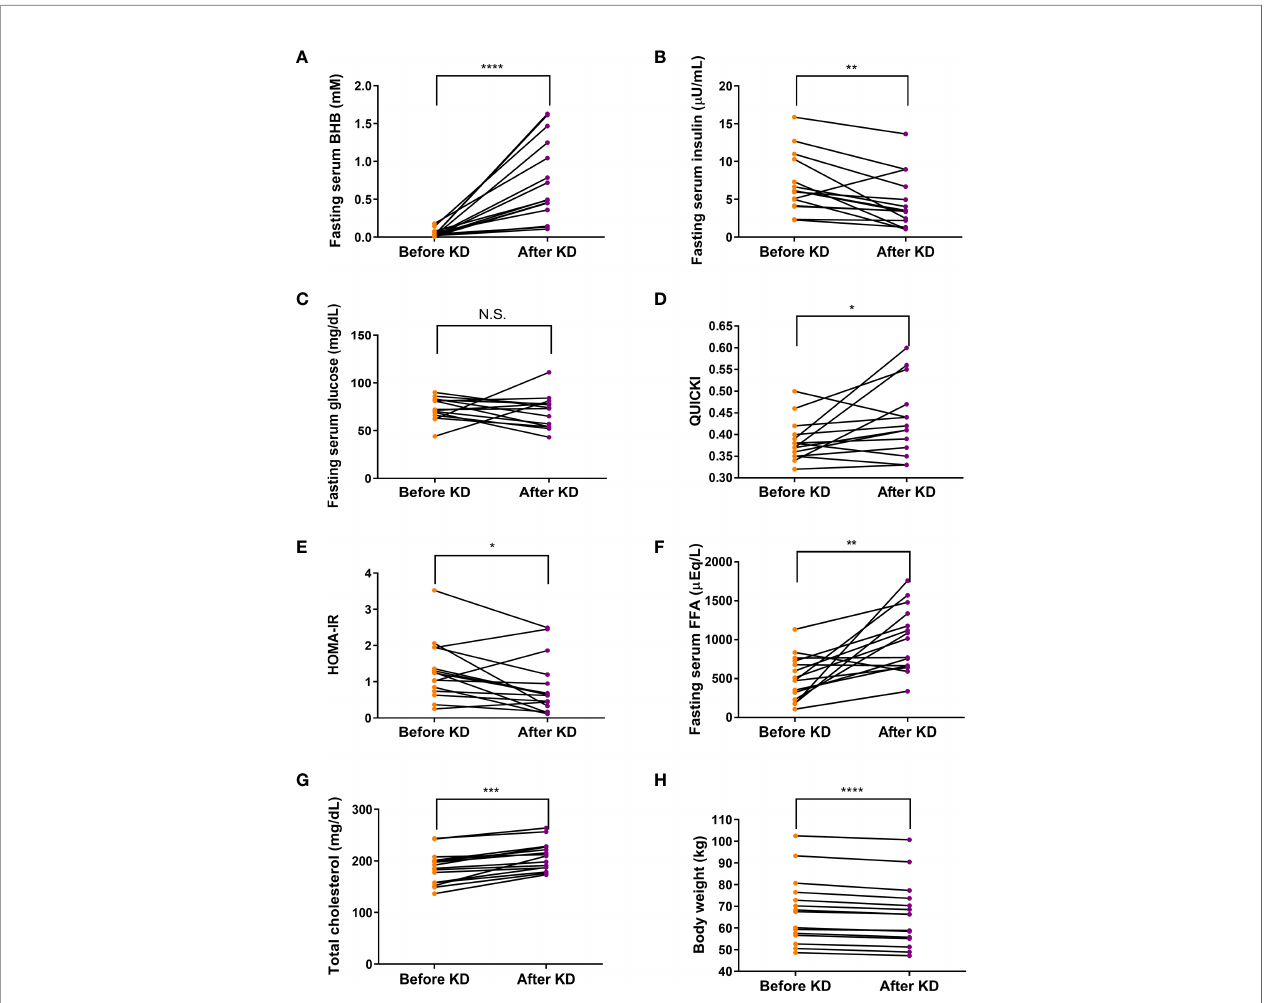
FIGURE 2 | Effects of isocaloric ketogenic diet on metabolic parameters. Fasting serum levels of BHB (A) , insulin (B) , glucose (C) , QUICK (D) , HOMA-IR (E) , FFA (F) , total cholesterol (G) from baseline to day 3 of isocaloric KD (H) ; Body weight changes from baseline to day 3 of isocaloric KD. Two-sided paired t-test or Wilcoxon signed rank test; * P < 0.05, ** P < 0.01, *** P < 0.001, and **** P < 0.0001 vs. baseline. BHB, b -hydroxybutyrate; FFA, free fatty acid; KD, ketogenic diet; QUICKI, quantitative insulin sensitivity check index; HOMA-IR, homeostatic model assessment of insulin resistance; N.S., non-signi fi